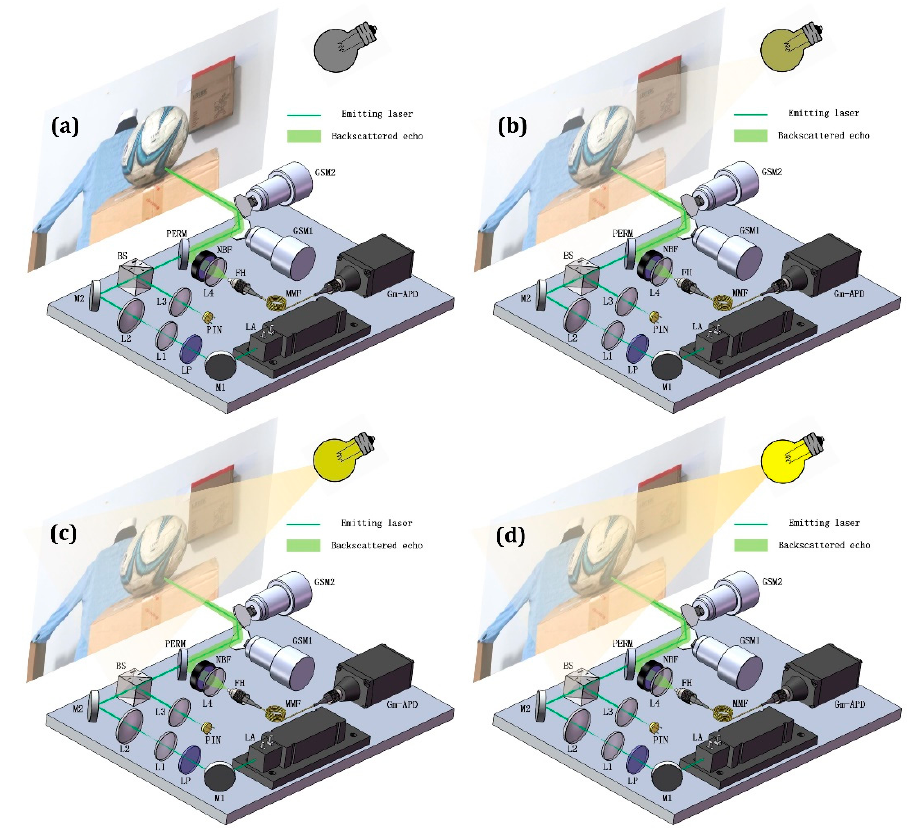
Figure A1. Demonstration of experiment details. ( a ) Dark experiment. ( b ) Low noise intensity ex- periment. ( c ) Middle noise intensity experiment. ( d ) High noise intensity experiment. experiment. ( c ) Middle noise intensity experiment. ( d ) High noise intensity